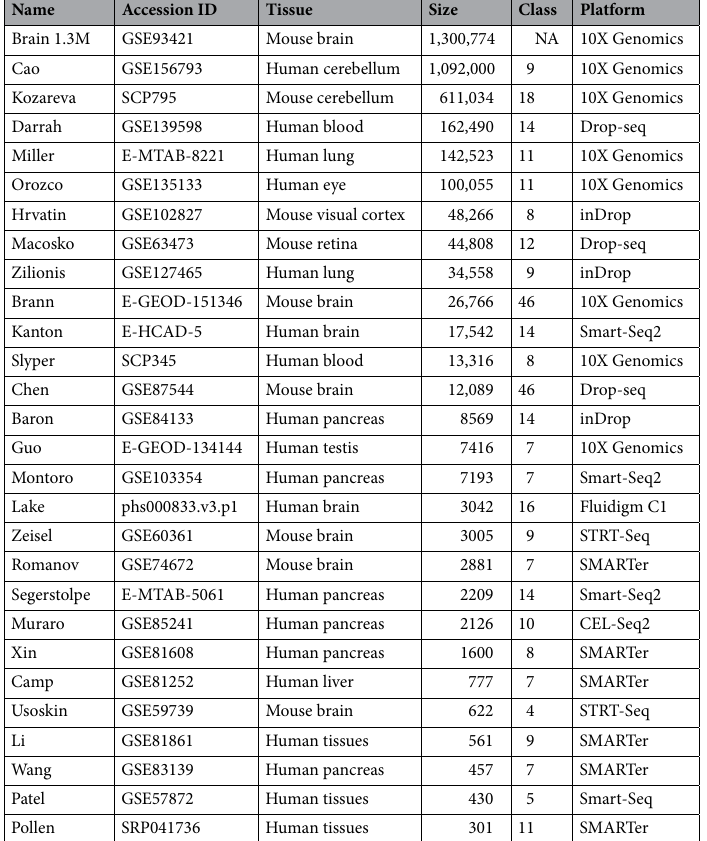
Table 1. Description of the 28 single-cell datasets used in our data analysis. The table shows the accession ID, tissue, number of cells, true number of cell types, and single-cell platform. All datasets except Brain 1.3M have true cell type information and thus can be used to assess the accuracy of the clustering methods. Each of the Cao and Brain 1.3M datasets has more than a million of cells and thus can be used to assess the scalability of the